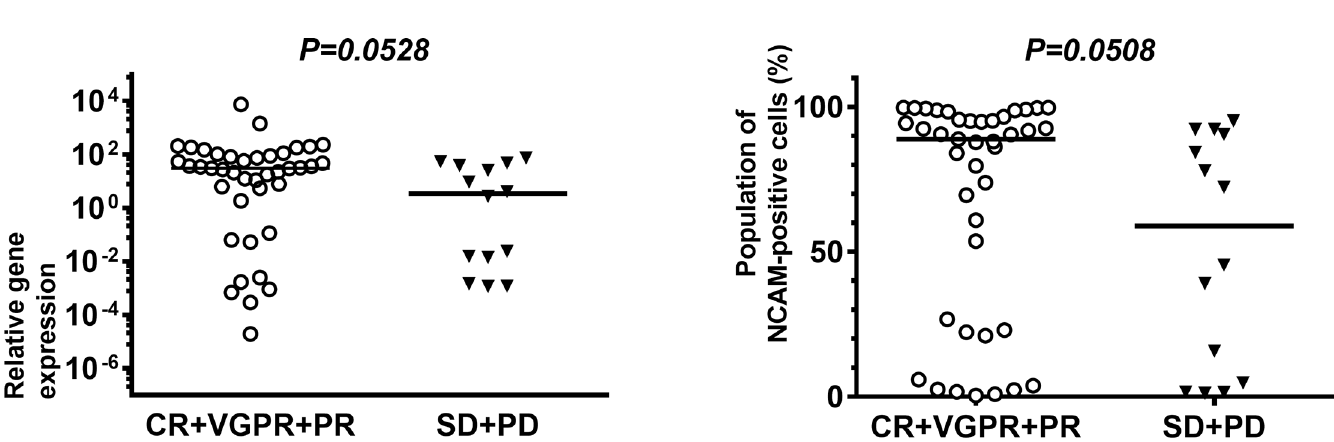
Fig 2. Comparison of levels of neural cell adhesion molecule (NCAM) among good and poor responders to bortezomib plus dexamethasone (Bd) therapy. Comparison of NCAM expression at the mRNA level (left side) and at the cell surface (right side) between the two groups, excluding seven t(14;16)-positive cases and 12 cases for which translocation of genes was not evaluated. (cid:3) indicates statistical significance ( p < 0.05), as calculated by a Mann–Whitney U test.